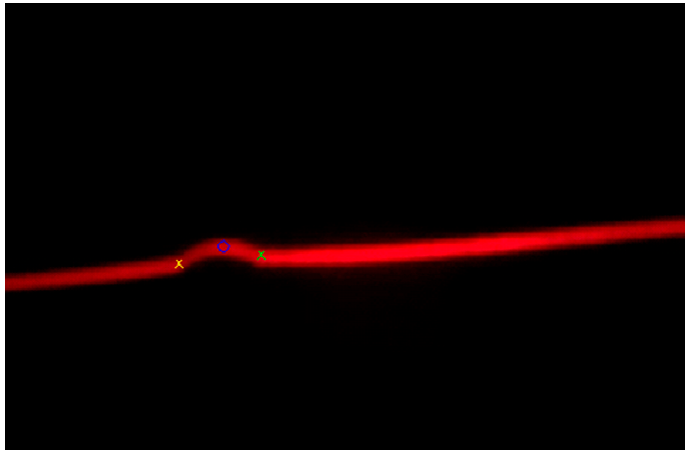
Figure 6. Second derivative of the one-pixel width laser profile after the welding operation.